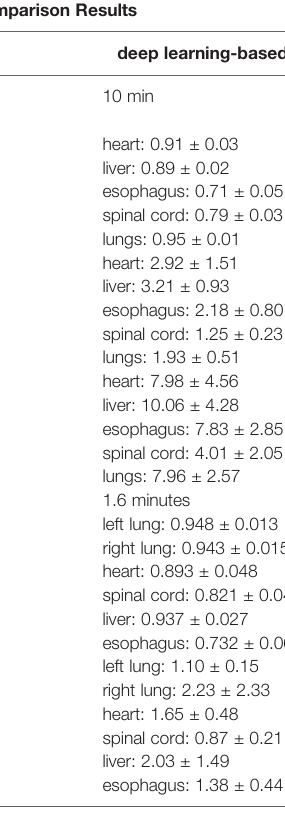
TABLE 9 | Selected works on comparison between atlas-based and deep learning-based automated segmentation.